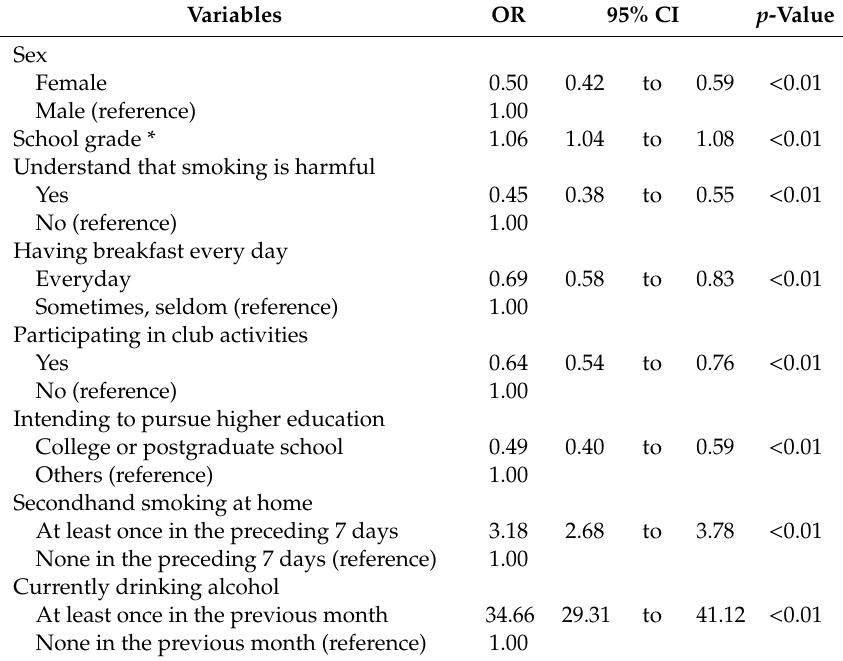
Table 4. Results of logistic regression: association between selected lifestyle variable factors and exclusive alternative products use ( n = 63,383).